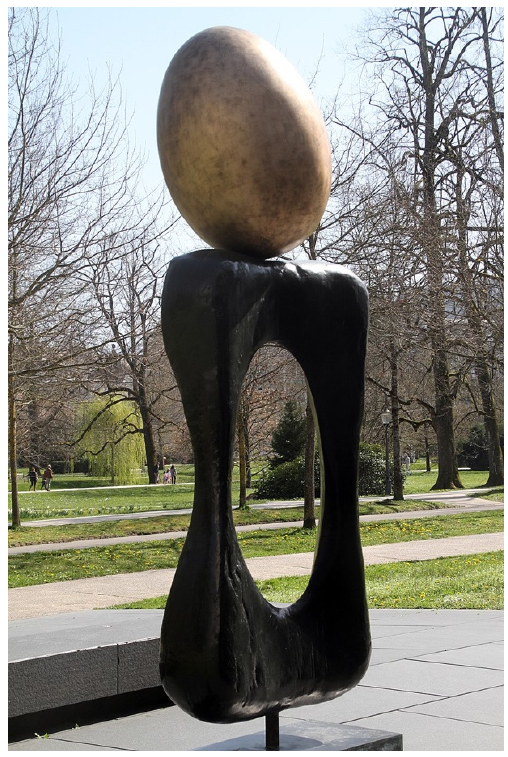
Figure 4. Joan Miró, Femme, 1970 . Photo by Gerd Eichmann, licensed under Creative Commons: CC BY-SA 4.0 .